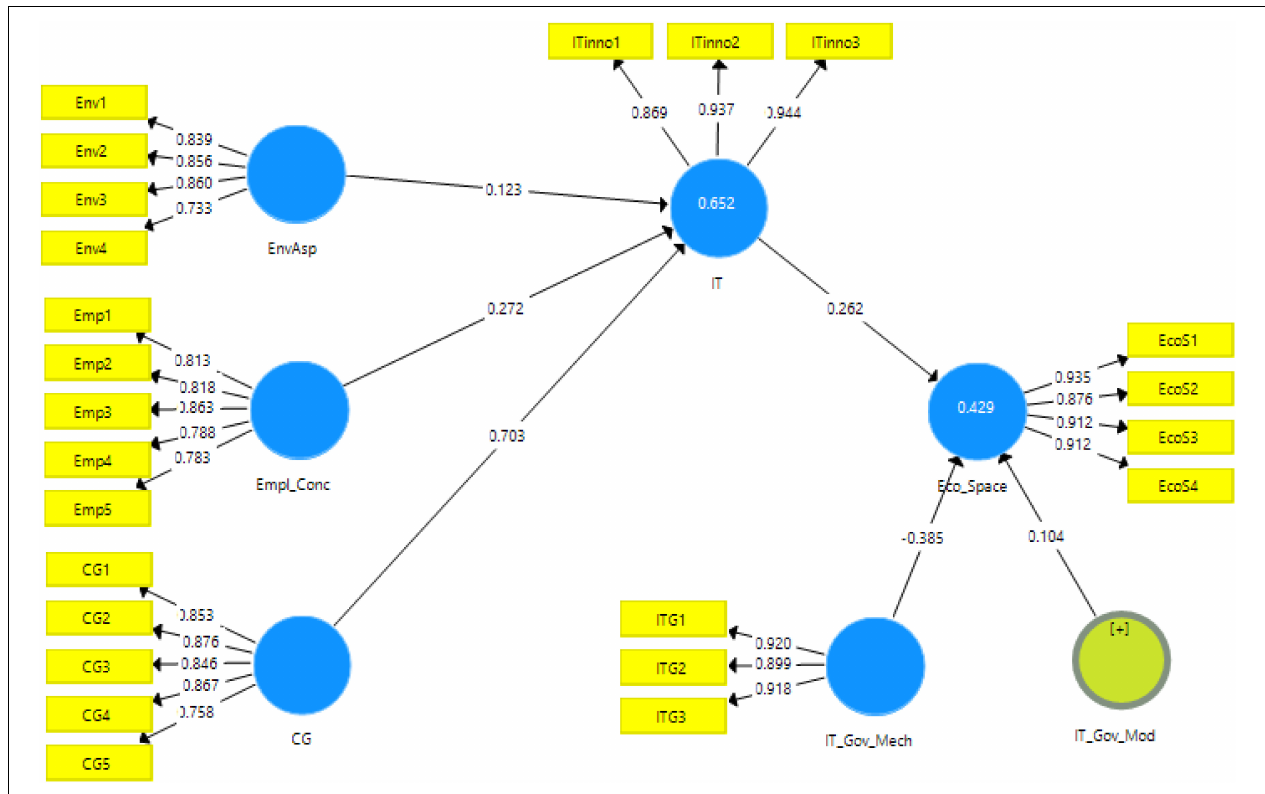
FIGURE 2 | Output of measurement model algorithm. EnvAsp, environmental aspect; Empl_Conc, concern for employees; CG, ethical and corporate governance awareness; Eco_Space, sustainable economic space; IT, technological innovation; IT_Gov_Mech, IT governance mechanism.